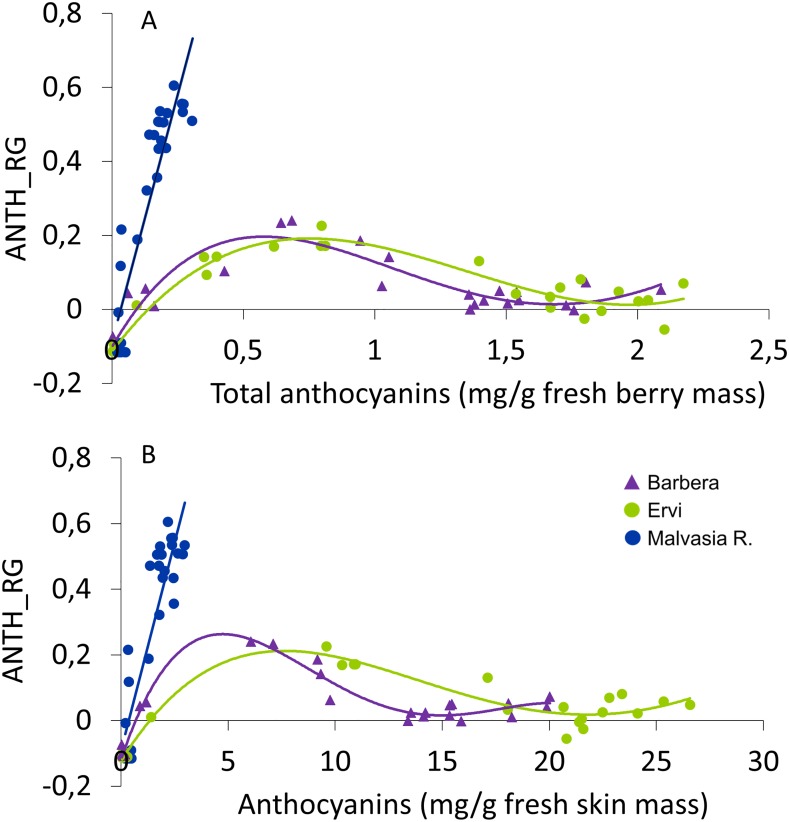
Correlation between seasonal field recorded ANTH_RG index and the ANTH concentrations determined by wet chemistry in three red cultivars with ANTH given on a berry mass fresh basis (A) and a skin mass fresh basis (B).In panel A, data taken on the low color-accumulating Malvasia R. fitted to the following linear model: y = 2.6675x − 0.0891, R2 = 0.82., n = 27. Data taken on Barbera and ERVI were instead fitted to the following polynomial models: y = -0.102x4 + 0.7315x3- 1.6365x2–1.2373x - 0.102, R2 = 0.85, n = 27 (Barbera) and y = -0.0081x4 + 0.2422x3–0.8925x2 + 0.9441x − 0.1142, R2 = 0.91, n = 27. In panel B, Malvasia R. data were fitted to the following linear model: y = 0.2527x − 0.0893, R2 = 0.79, n = 27. Polynomial models run through Barbera and Ervi data were: y = -3E-05x4 + 0.0018x3- 0.0319x2 + 0.1946x − 0.1191, R2 = 0.94, n = 27 (Barbera) and y = -4E-06x4 + 0.0004x3- 0.0106x2+0.1057x -0.1238, R2 = 0.91, n = 27.